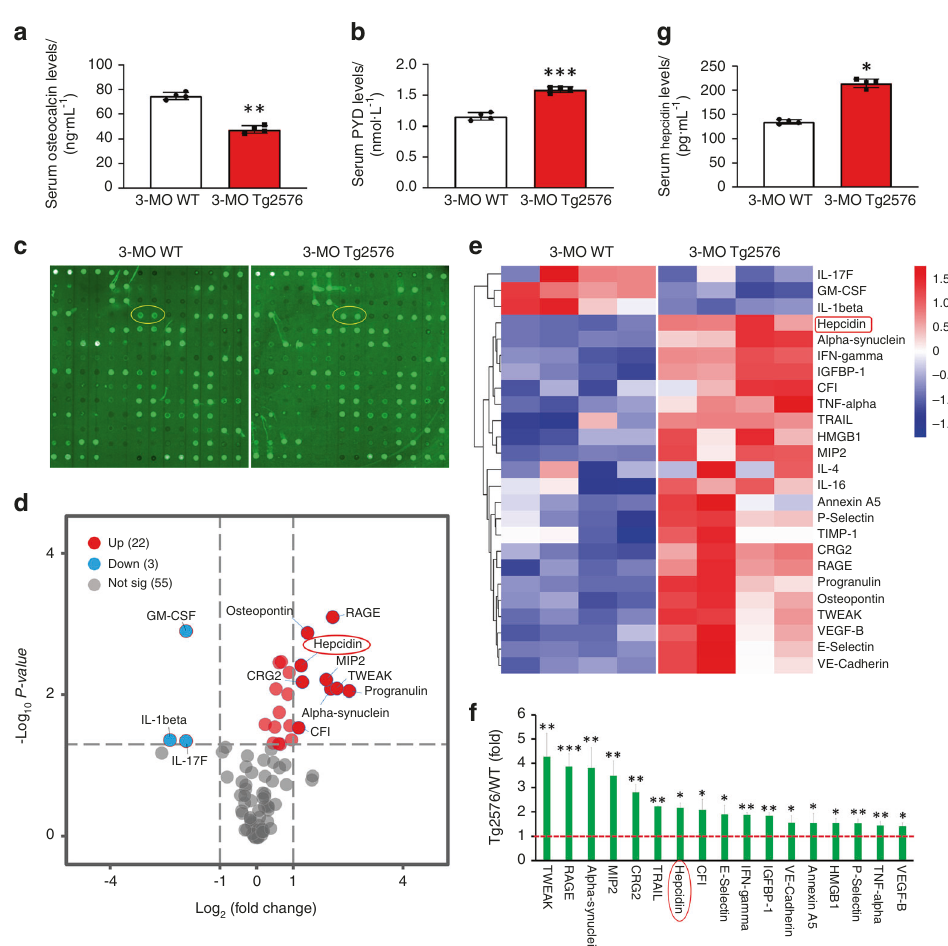
Fig. 1 Increased expression levels of hepcidin in serum samples from 3-month-old Tg2576 mice. a Serum osteocalcin (Ocn) levels in 3-month- old WT and Tg2576 mice. Serum osteocalcin levels were measured by ELISA. The mean ± SD of measurements from four males per genotype are shown. ** P < 0.01 (signi fi cant difference). b ELISA analysis of serum pyridinoline (PYD) levels. The mean ± SD ( n = 4) are presented. *** P < 0.001 (signi fi cant difference). c Proteome pro fi le of the sera of 3-month-old WT and Tg2576 mice, as determined by a mouse cytokine array. Hepcidin is marked with a yellow circle. d Volcano plot of the Tg2576/WT Log 2 ratio (fold change). The upregulated proteins are marked in red, and the downregulated proteins are indicated in blue ( P < 0.05). e Heat map of the protein expression z-scores computed for the 25 proteins that are differentially expressed in the sera of 3-month-old Tg2576 mice ( P < 0.05). f The fold change in the expression of 17 proteins in the sera of 3-month-old Tg2576 mice. These proteins also showed the same changes in 7-month-old Tg2576 mice. * P < 0.05; ** P < 0.01; *** P < 0.001 (signi fi cant difference). g Analysis of serum hepcidin levels in 3-month-old WT and Tg2576 mice by ELISA. * P < 0.05 (signi fi cant (Supplementary Fig. S4f – j) and TgHamp1-Ocn mice (Supplemen- tary Fig. S5f – j) but undetectable in 1-month-old mutant mice (Supplementary Fig. S4a-e, Supplementary Fig. S5a – e). These osteoporotic changes were detected in both male but female TgHamp1-Alb and TgHamp1-Ocn mice (Supplementary Fig. S4k – o, Supplementary Fig. S5k – o). Together, these results suggest that hepcidin derived from either hepatocytes or OB lineage cells plays a negative role in maintaining trabecular bone mass. Impaired OB-mediated bone formation in TgHamp1-Ocn, but not TgHamp1-Alb, mice Bone mass is determined by OB-mediated bone formation and OC-mediated bone resorption. We thus examined both processes in TgHamp1-Alb, TgHamp1-Ocn, and control mice. Bone formation was fi rst evaluated by injecting fl uorochrome-labeled calcein green into 3-month-old TgHamp1-Alb, TgHamp1-Ocn, and control littermates twice at a 10-d interval. The mineral apposition rate (MAR), mineral surface/bone surface (MS/BS), and bone formation rate (BFR) in both the endocortical (Ec.) and trabecular (Tb.) bone